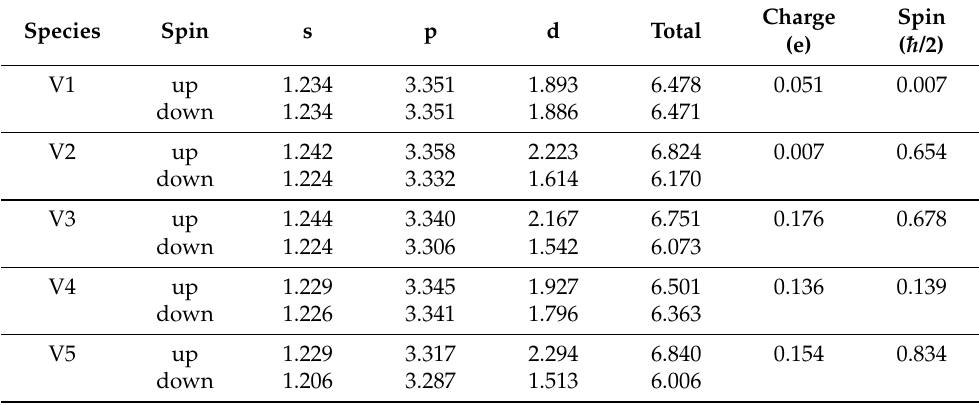
Table A3. Atomic populations (Mulliken) for mq As 2 S 3